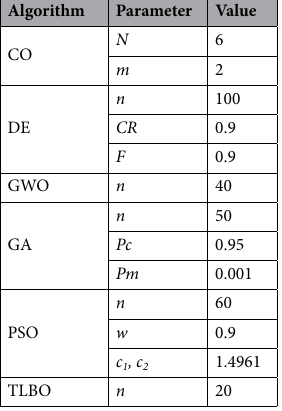
Table 2. Parameter setting of competing algorithms for solving 500-D shifted CEC2005 test